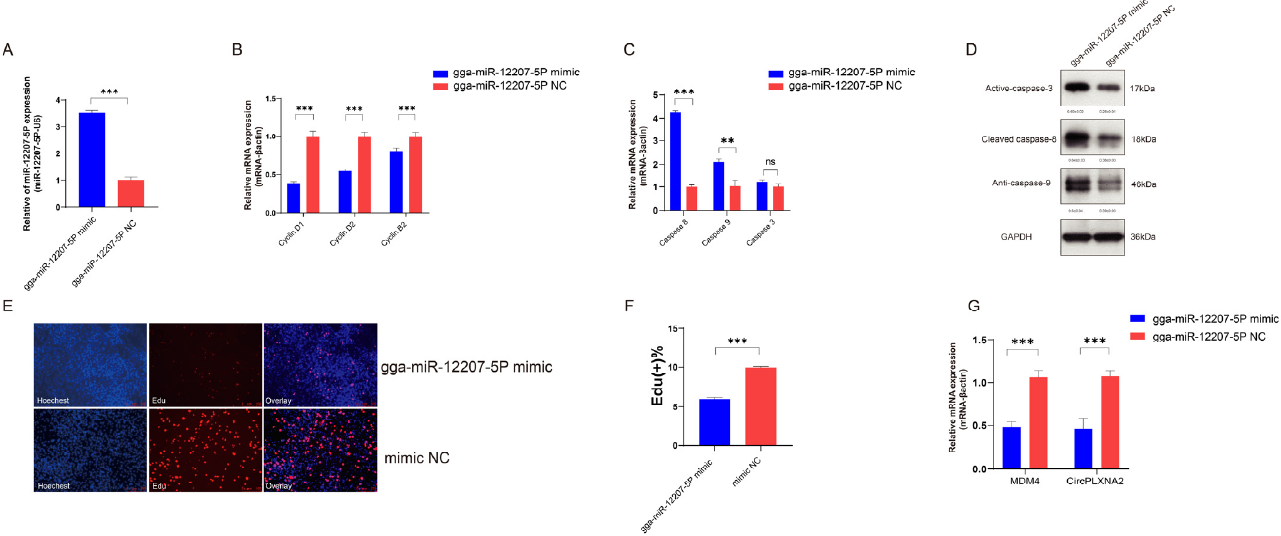
Figure 5. gga ‐ miR ‐ 12207 ‐ 5P inhibited cell proliferation and promoted cell apoptosis. ( A ) The over ‐ Figure 5. gga-miR-12207-5P inhibited cell proliferation and promoted cell apoptosis. ( A ) The over- expression efficiency of gga ‐ miR ‐ 12207 ‐ 5P in myoblasts after transfection with gga ‐ miR ‐ 12207 ‐ 5P expression efficiency of gga-miR-12207-5P in myoblasts after transfection with gga-miR-12207-5P mimic. ( B ) qRT ‐ PCR results of cyclin D1, cyclin D2, and cyclin B2 after gga ‐ miR ‐ 12207 ‐ 5P overex ‐ mimic. ( B ) qRT-PCR results of cyclin D1, cyclin D2, and cyclin B2 after gga-miR-12207-5P overex- pression. ( C , D ) mRNA level ( C ) and translation level ( D ) of caspase 3, caspase 8, and caspase